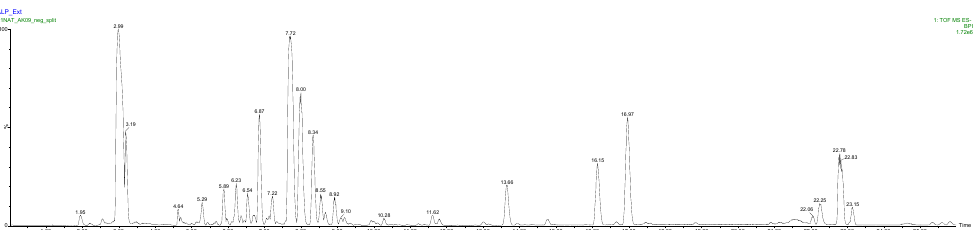
Figure 4. LC/MS chromatogram (BPI) of the glycerol/water Alpine rose extract—negative ion mode—ESI source. Table 1. Summary of LC/MS data.